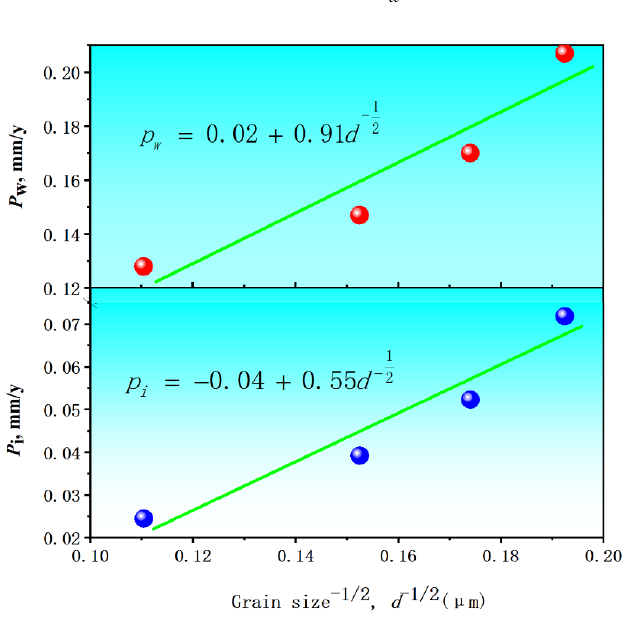
Figure 7. The relation between the biodegradation rate ( P i or P w ) and the average ferrite size ( d